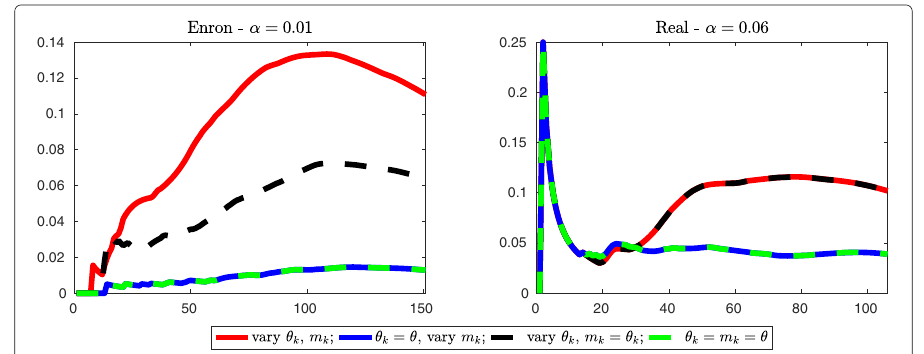
Fig. 14 Further reduction. Evolution of the intersection similarity between (cid:12) Q [ M ] 1 and Q [ M ] 1 when the former is computed using one among (4), (6a), (6b), or (6c). In the computations, θ = 10 − 5 for the network Enron and θ = 10 − 4 for the network Real